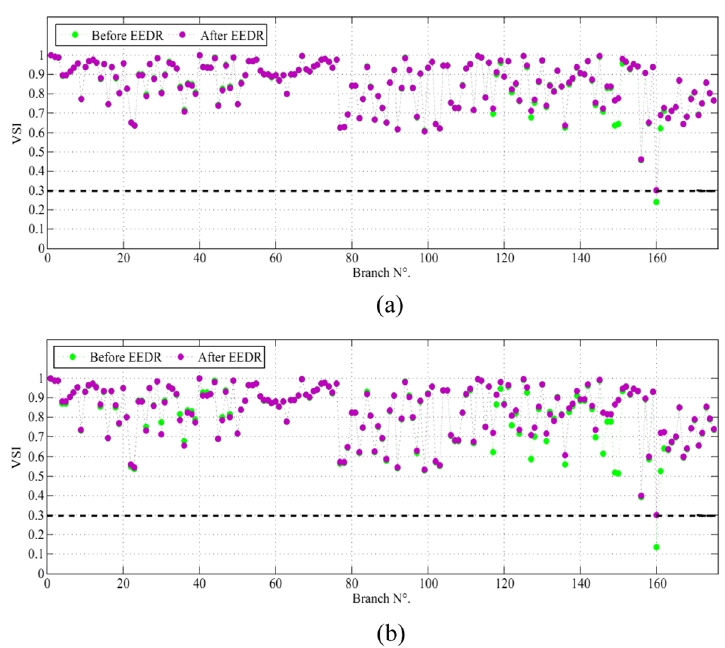
Fig. 17 VSI of the Algerian 114-bus system in the case of (a) increasing of load by 20%, (b) increasing of load by 35%